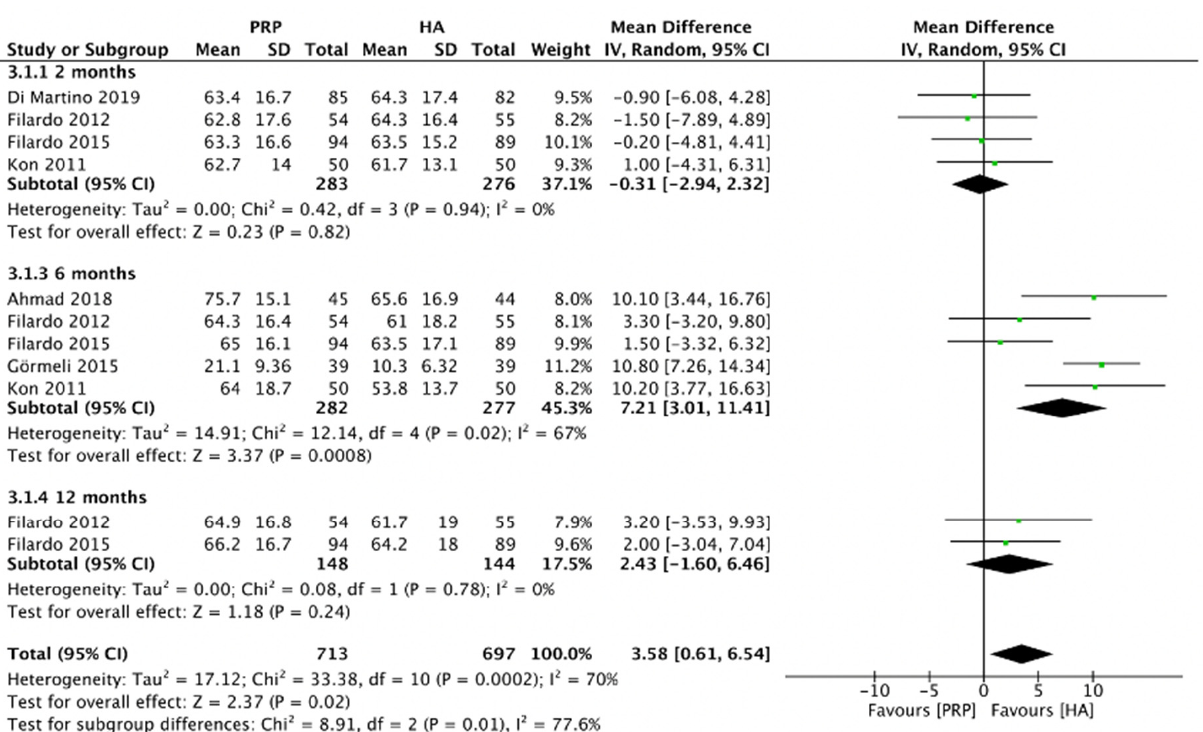
Figure 9. Trials of LR-PRP versus HA. Forest plot of IKDC scores. (IV, inverse variance; CI, confidence interval; SD, standard deviation).